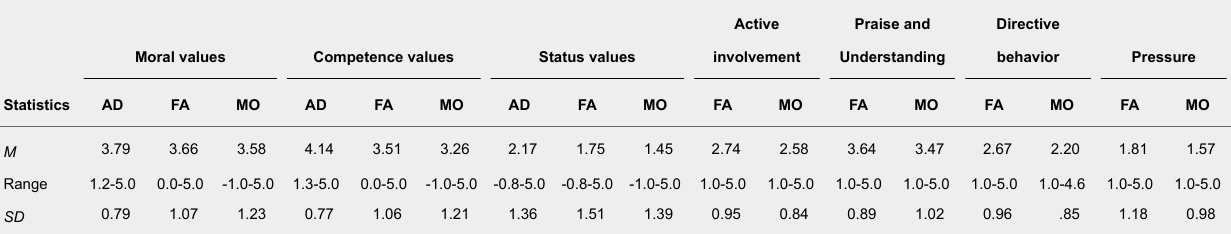
Adolescents’ Sport Values, Perceptions of Parents’ Sport Values and of Parental Involvement in Sport